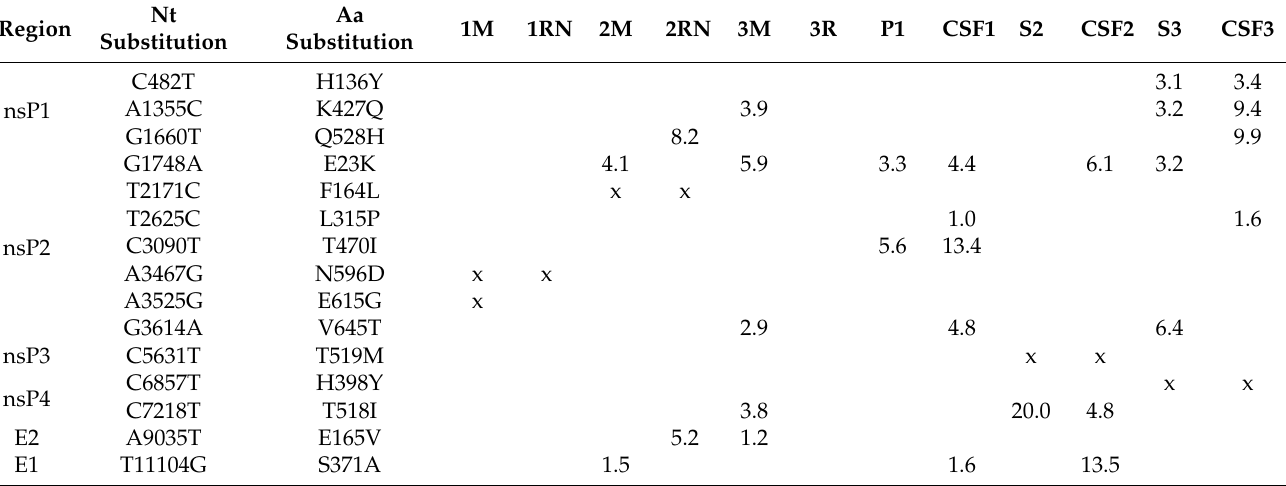
Table 1. Non-conservative iSNV/SNPs repeatedly detected in samples. Numbers in each sample’s column represent the intrahost frequency of the variant within the sample (for iSNVs), while